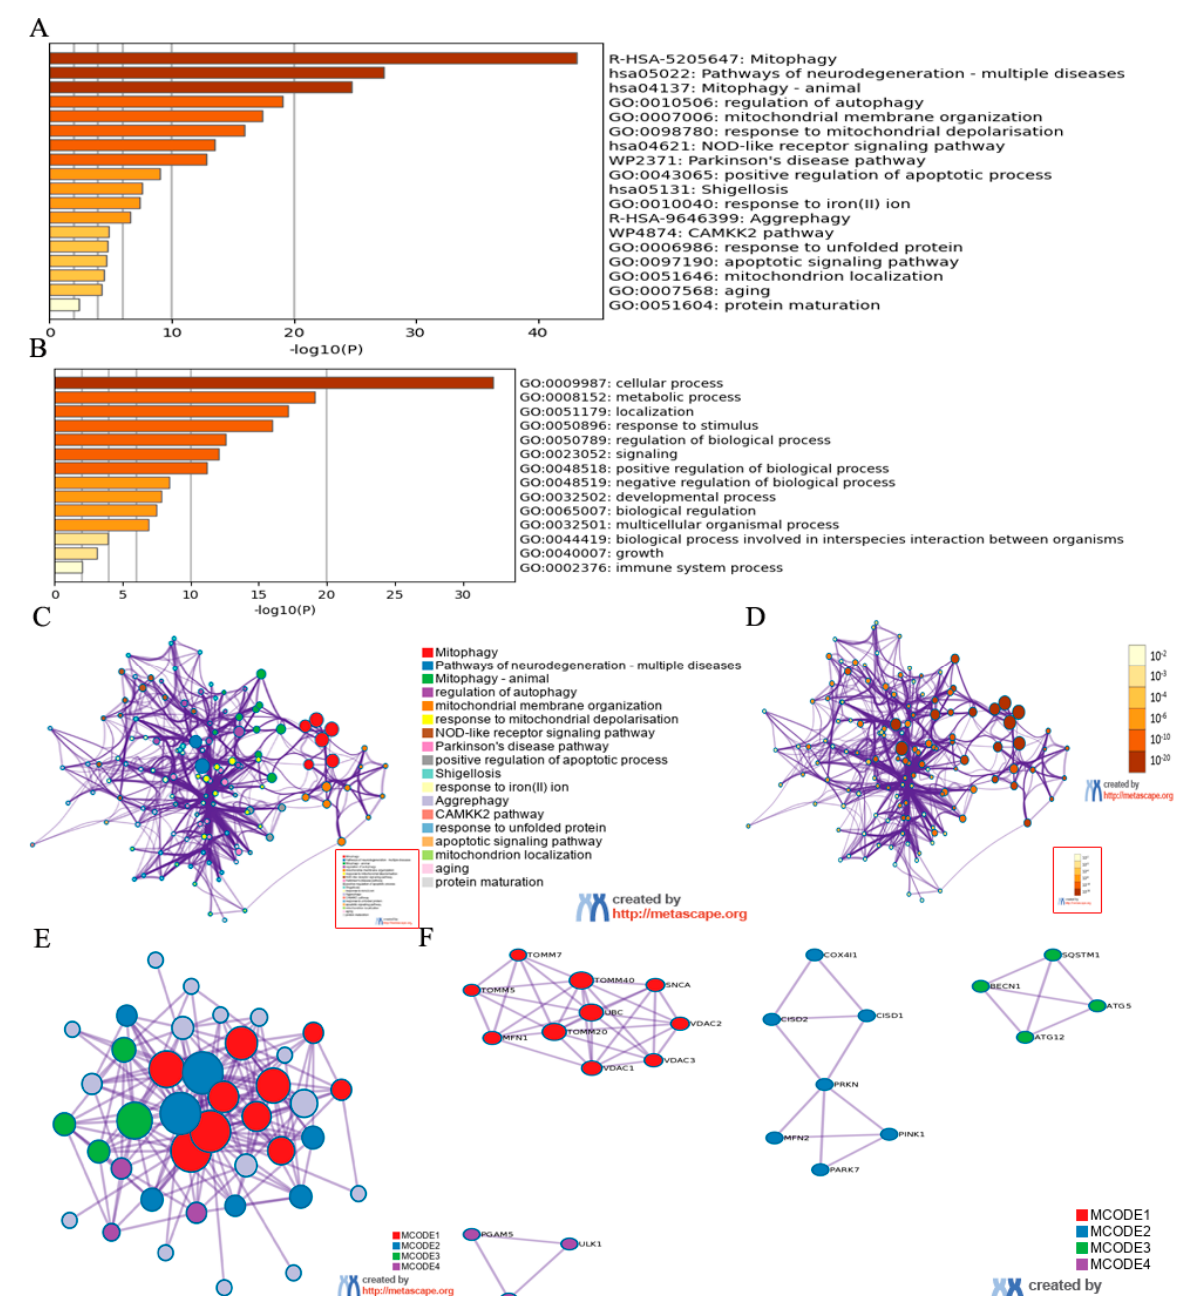
Figure 2. Identification of mitophagy regulators by Metascape Online Analysis. ( A ) Bar graph of enriched terms across input mitophagy regulator lists, colored by p -values. ( B ) The top-level Gene Ontology biological processes can be viewed here. ( C ) Network of enriched terms: col- ored by cluster ID, where nodes that share the same cluster ID are typically close to each other. ( D ) Colored by p -value, where terms containing more genes tend to have a more significant p -value. ( E , F ) Protein-protein interaction network and MCODE components identified in the mitophagy regulator